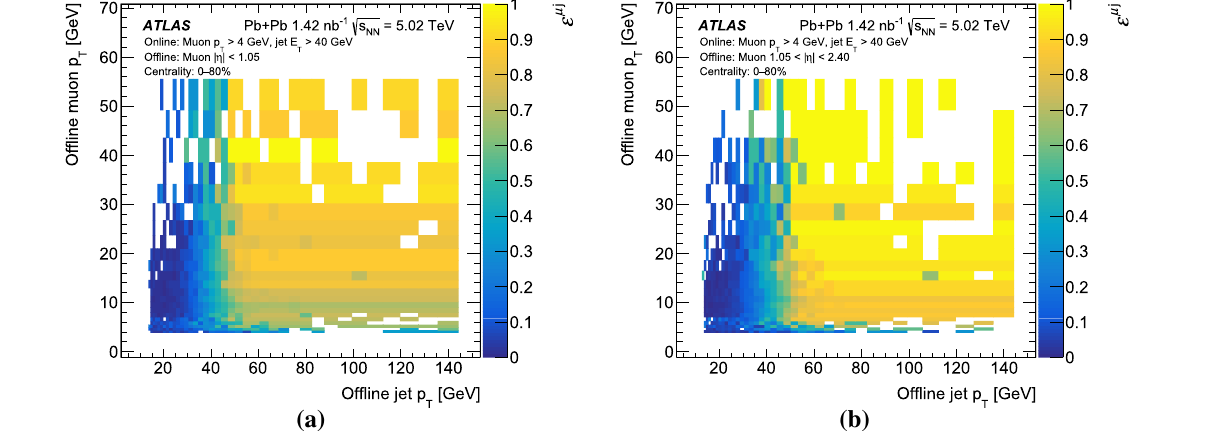
sively across the full collision centrality range (0–80%) for the a barrel and b endcap regions. The last bins of both the x - and y -axes contain